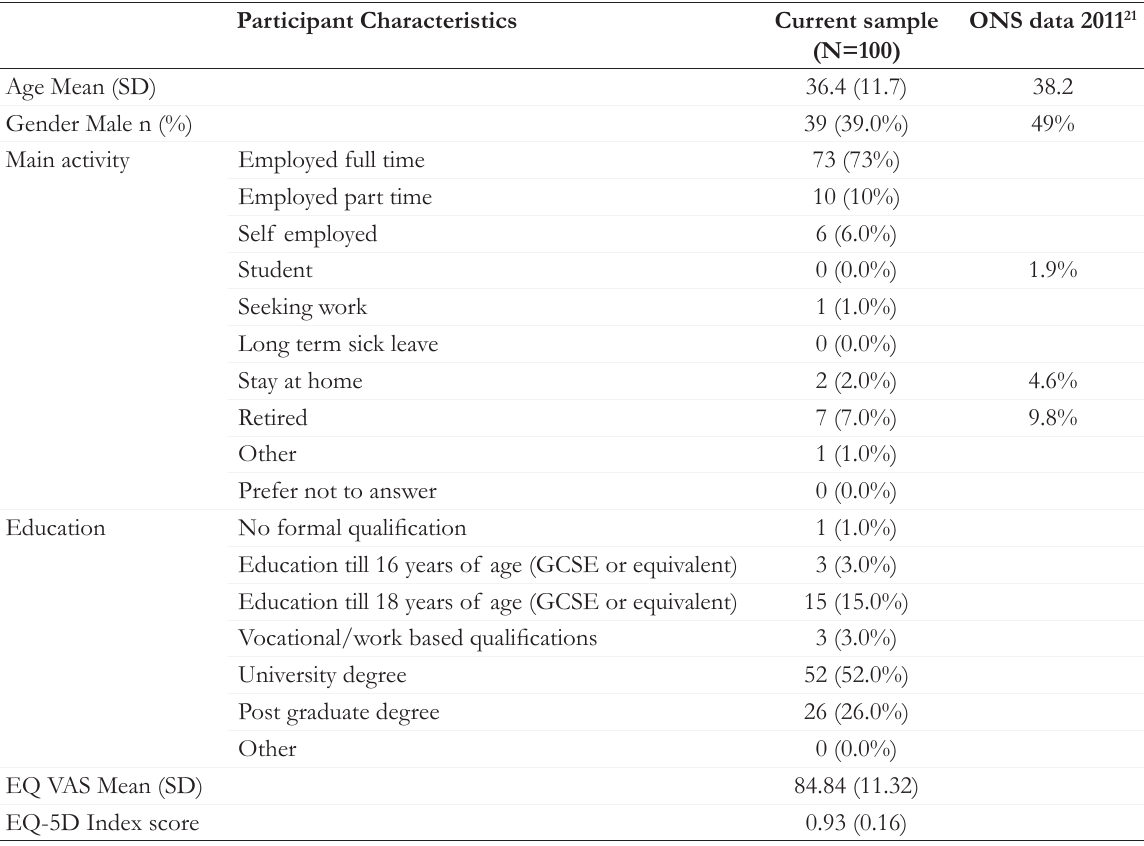
Table 1: Socio-demographic Profile of the